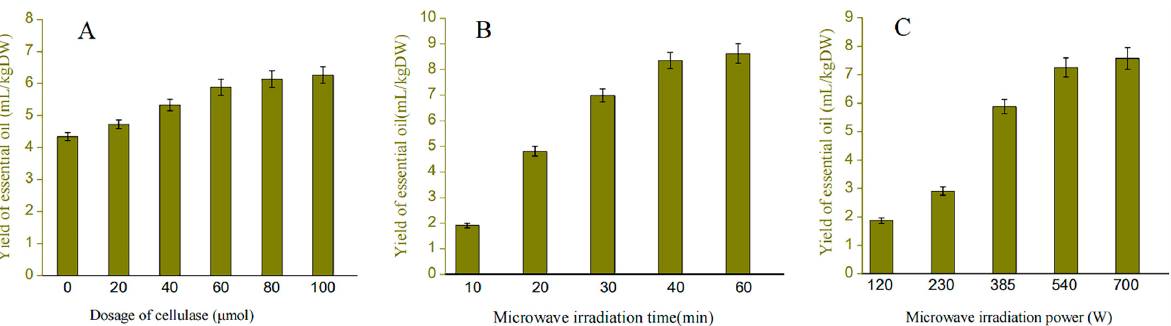
Figure 1. The yield of essential oil effected by different factors. Figure ( A – C ) respectively repre- sents the effects of pectinase addition amount, microwave time and microwave power on the yield of essential